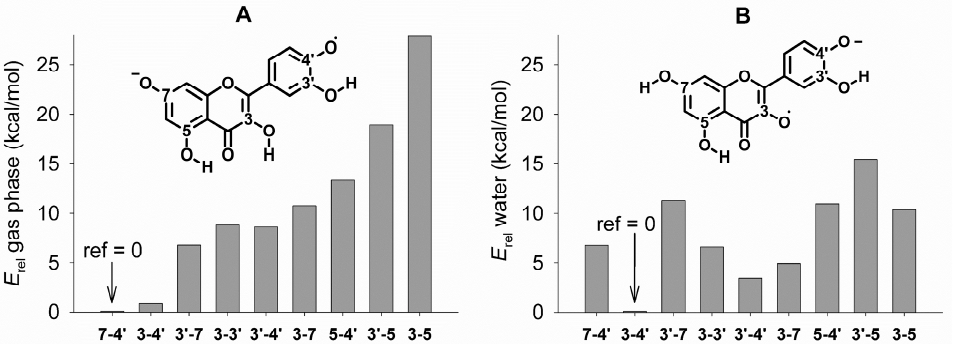
Figure 4. Relative stability of the radical anions obtained by H ‐ atom abstraction from deprotonated quercetin, calculated in the gas phase ( A ) and in water ( B ), determined from the relative energy ( E rel ) with reference to the most stable species (ref = 0). Numbers on the x ‐ axis indicate the position of the radical and of the negative charge. The radical anion in 5 ‐ 7 is omitted for clarity ( E rel is 32.7 and 21.0 kcal/mol in the gas phase and water, respectively).